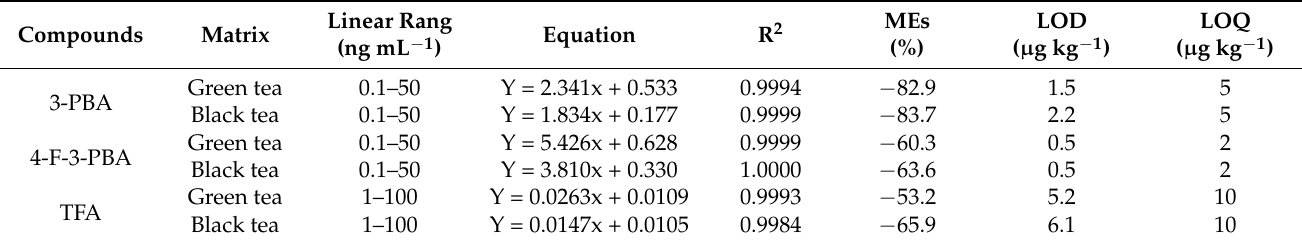
Table 4. Linear range and equation with correlation coefficient (R 2 ), matrix effect (ME, %), the limit of detection (LOD, µ g kg − 1 ), and the limit of quantification (LOQ, µ g kg − 1